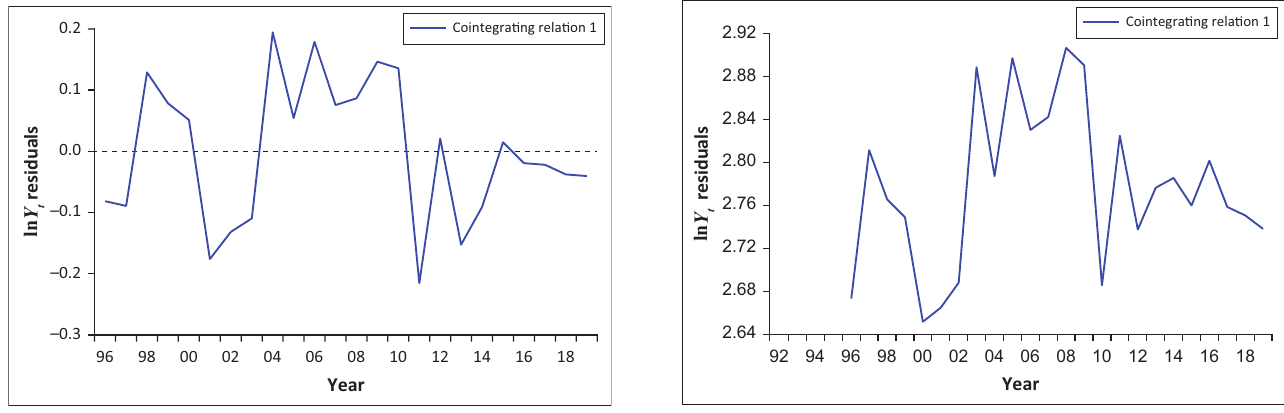
FIGURE 10: Cointegration relationship, autoregressive distributed lag